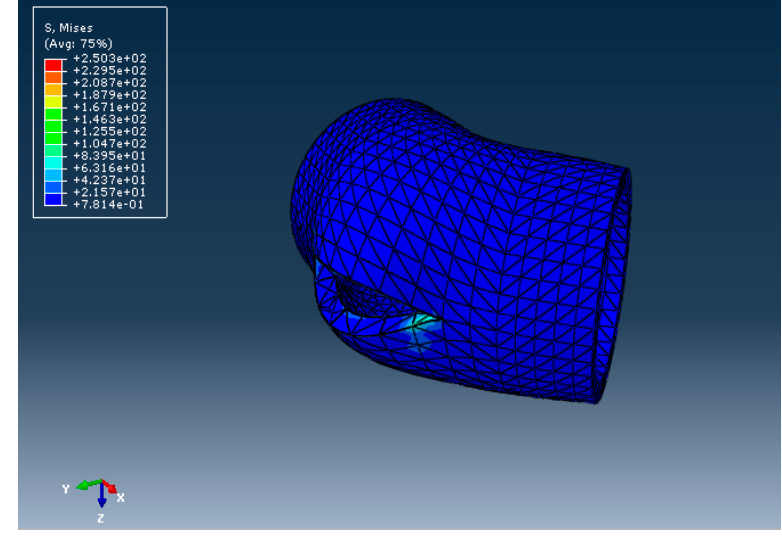
Figure 31. Elbow DN 315 after cracking.